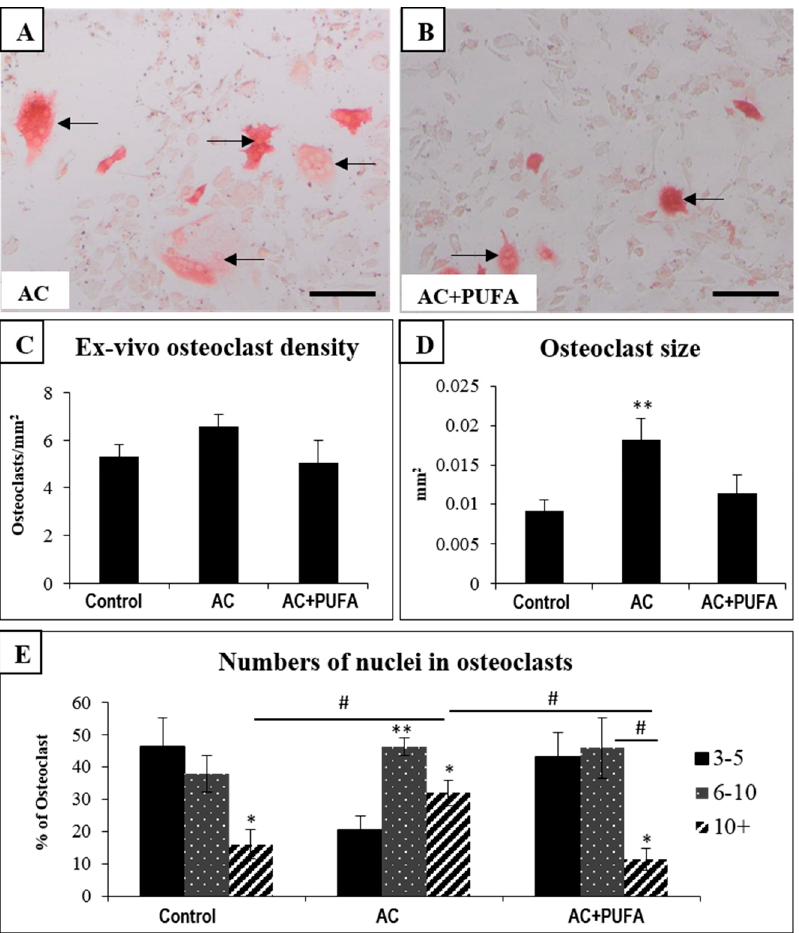
Figure 5. Effects of daily omega-3 polyunsaturated fatty acid (PUFA) supplementation during weekly AC treatment on ex vivo osteoclast formation potential. Ex vivo osteoclast formation from bone marrow cells of an AC-treated rat ( A ) and from bone marrow cells of AC + PUFA-treated rat ( B ); with arrows pointing to multinucleated tartrate-resistant acid phosphatase-stained osteoclasts. Treatment effects on the ex vivo osteoclast formation ability ( C ); size of osteoclasts formed ( D ); and numbers of nuclei within osteoclasts formed ( E ) (* or ** compared to the respective group with 3–5 nuclei). Scale bar on all panels = 100 µm. # above horizontal bars reflects differences between connected groups. Significant values are indicated as: * or # = p < 0.05 and ** = p < 0.01.